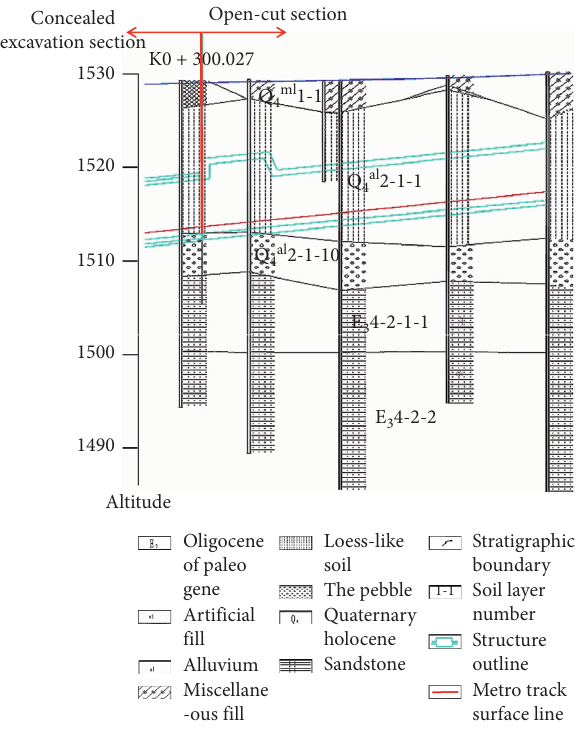
Figure 2: Geological